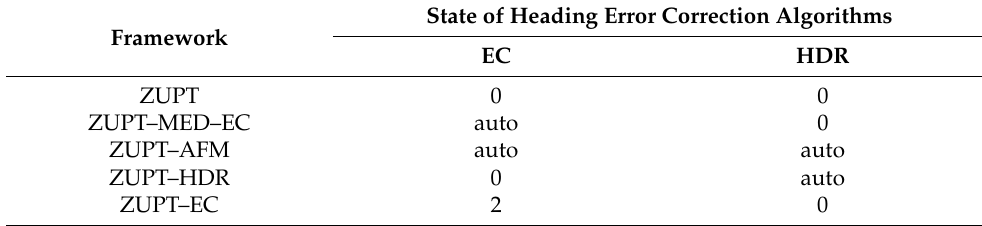
Table 2. Generating different frameworks using our proposed framework.